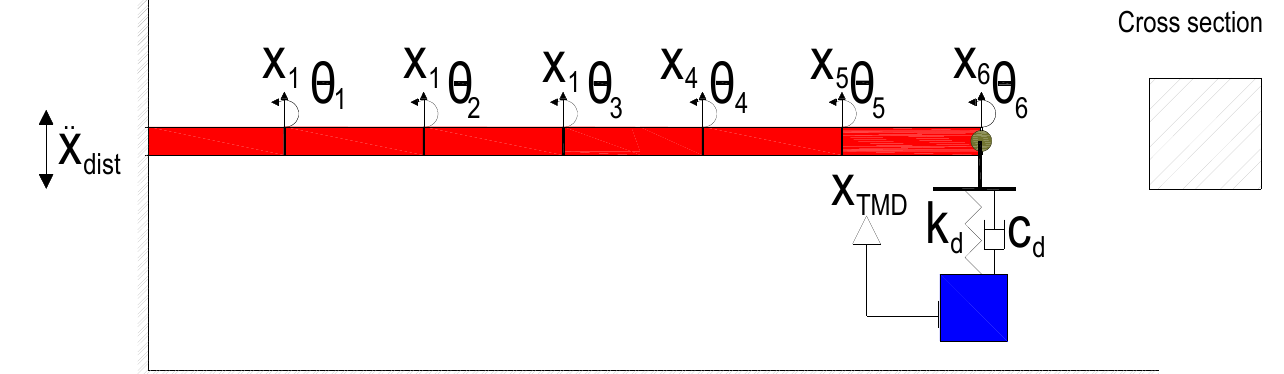
Figure 3. Cantilever beam–TMD model with six nodes.